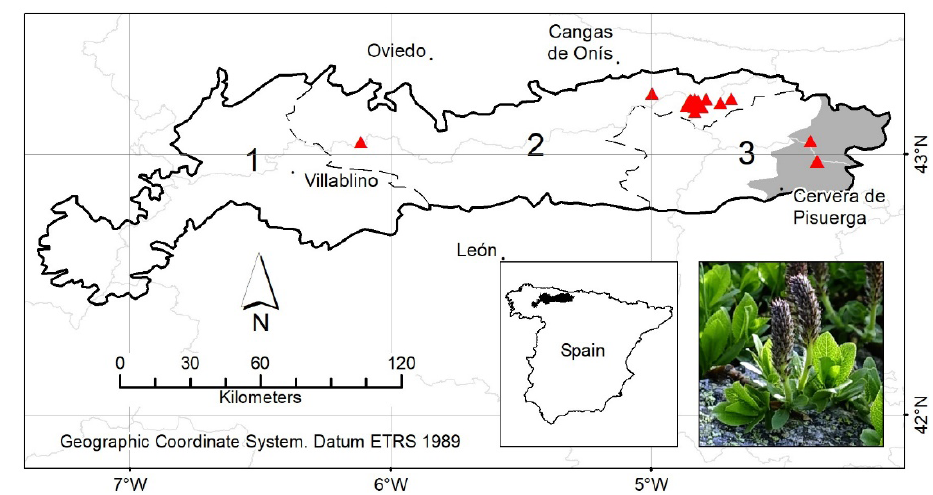
Figure 1. Orocantabrian biogeographical Subprovince and Salix breviserrata s.l. occurrences in the Iberian Peninsula (red triangles). 1: Laciana and Ancares Sector, 2: Picos de Europa and Ubiña Sector, 3: High Campoo and Carrión Sector. Shaded in grey: High Campoo